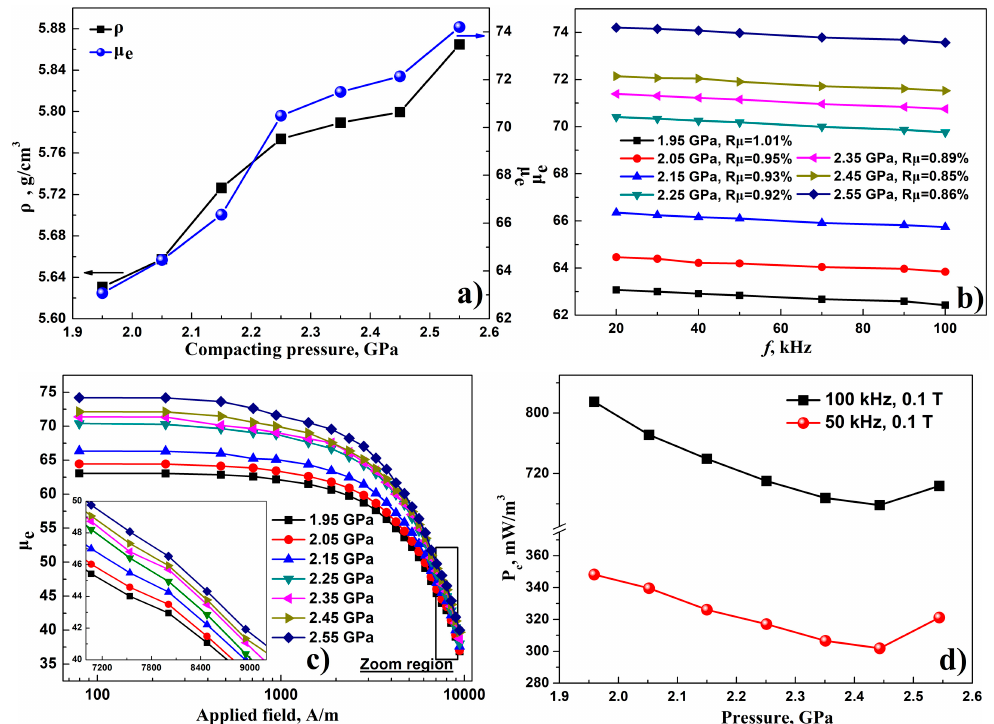
Figure 5. Dependence of the molding pressure on the compact density, the effective permeability ( a ), the frequency characteristic ( b ), the DC-bias performance ( c ), and the core loss ( d ) for the AMPCs.